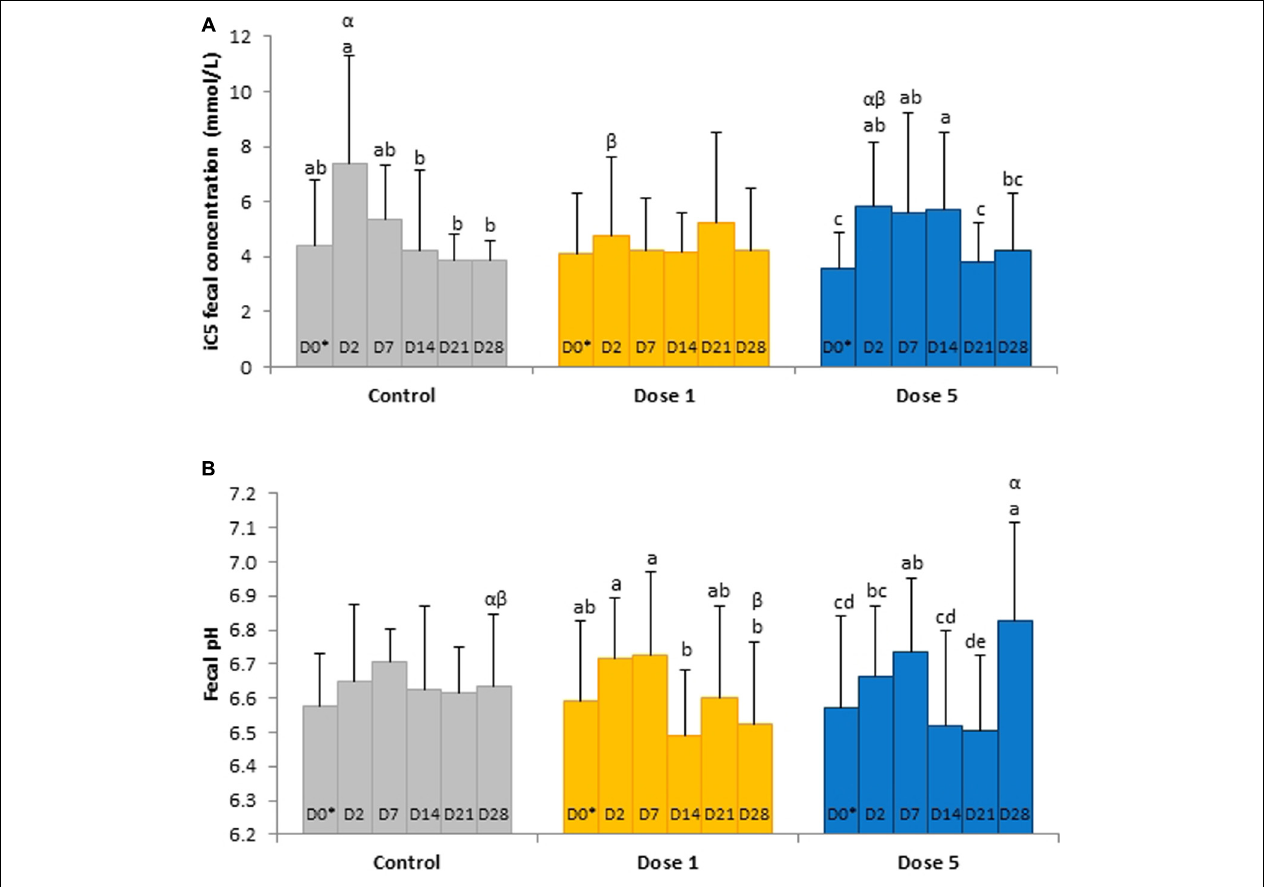
FIGURE 4 | Depiction of significant day × supplementation interactions regarding (A) isovaleric acid concentrations and (B) pH in fecal samples from horses subjected to an oral challenge with TMS from D0 to D4 by day. Different Latin letter superscripts show significant variations between days for each supplementation. Different Greek letter superscripts indicate significant variations between supplementations for each day. ∗ D0: Basal value before the first TMS